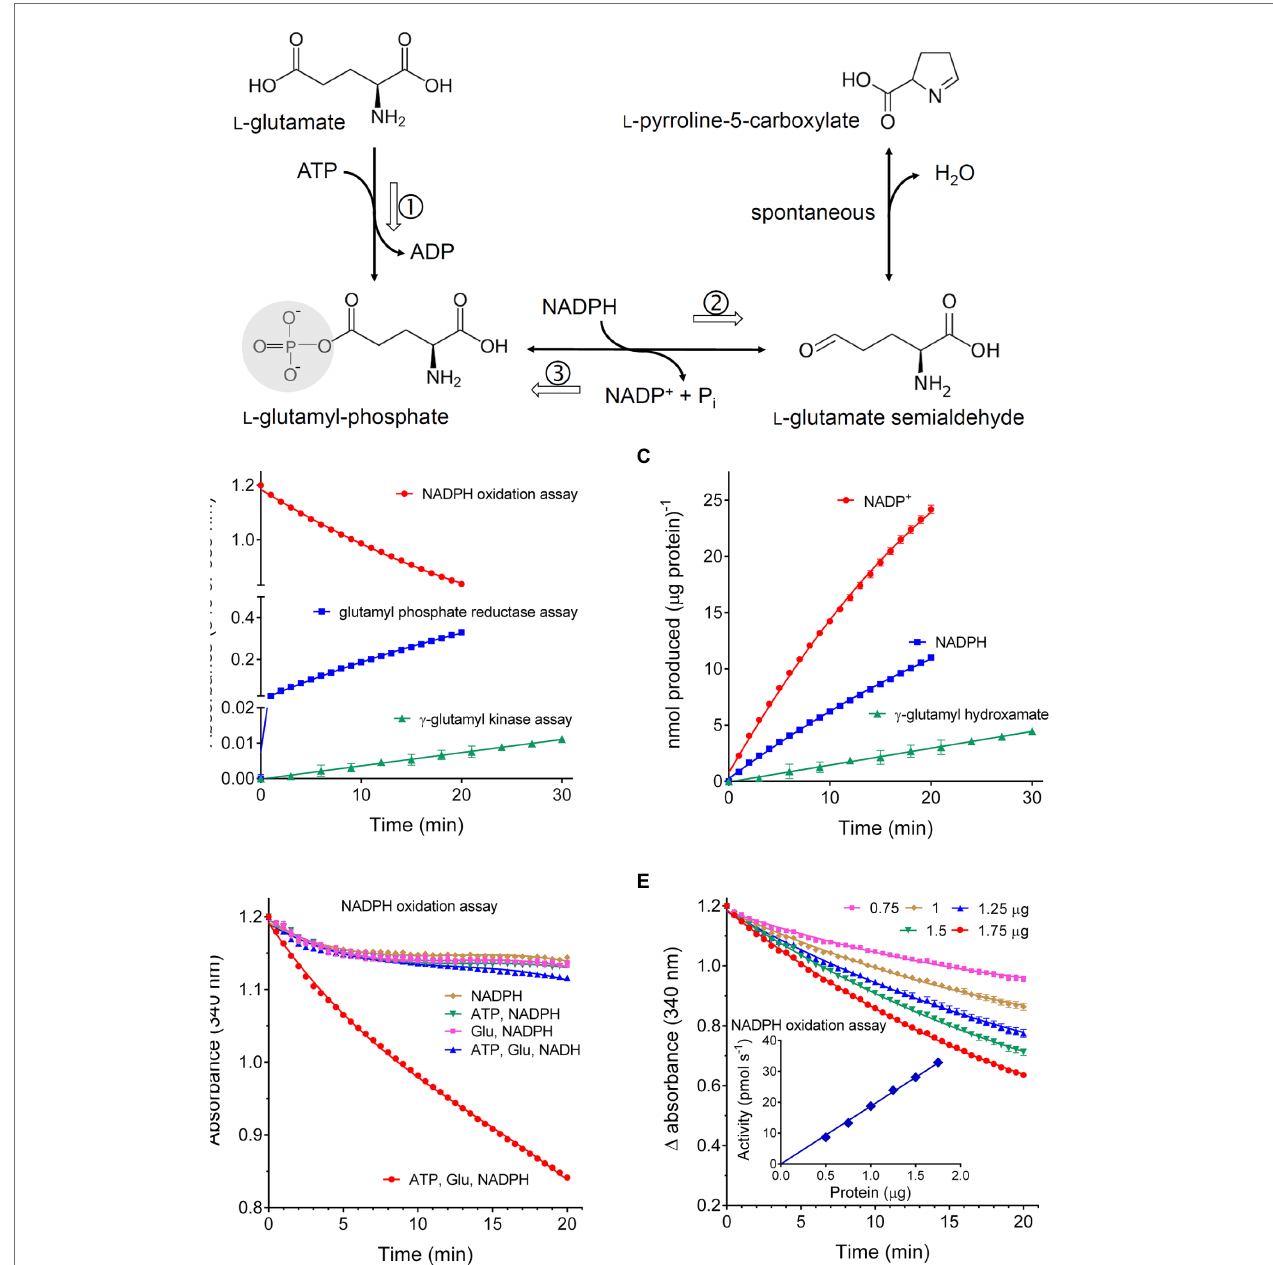
FIGURE 2 | Activity of recombinant rice P5C synthetase 2. (A) shows the reaction catalyzed by the enzyme: following glutamate phosphorylation and ADP release, glutamyl-phosphate is reduced using NADPH as the electron donor, yielding glutamate semialdehyde that spontaneously cyclizes to P5C. Three assay methods have been described: the glutamate kinase assay, which measures the formation of γ -glutamyl-hydroxamate in the absence of NADPH ( ① ); the glutamyl-phosphate reductase assay, which follows the reverse, P5C- and Pi-dependent reduction of NADP + in the absence of glutamate ( ③ ); the NADPH oxidation assay in the presence of all three substrate, thereby following the full forward, physiological reaction of the enzyme ( ① + ② ). The purified protein was assayed with these three methods using aliquots corresponding to 2, 2, and 1 μ g protein, respectively (B) . To obtain a quantitative comparison of the three methods, data in (A) were used to calculate the absolute amounts of the product formed in each case per μ g of protein (C) . The NADPH oxidation assay was performed by incubating 1 μ g of the purified protein with 0.4 mM NADPH in the presence of an array of all possible combinations of the other substrates. A mixture containing ATP and NADH instead of NADPH was also included. Non-limiting levels of all three substrates were required to maintain the rate of NADPH oxidation over time (D) . Because an initial burst of NADPH consumption was evident also in the absence of ATP and glutamate, the activity of increasing amounts of protein was measured against exact blanks in which glutamate had been omitted (E) . The inset shows that in this case activity values, calculated by interpolation of the linear rate of NADPH oxidation, were strictly proportional to the amount of the enzyme. In all cases, results are means ± SE over three technical replications. Each experiment was repeated three times with different enzyme preparations, obtaining very similar